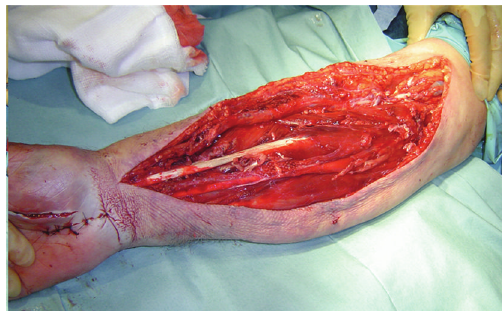
Figure 2: Fasciotomy with extensile Henry’s approach for forearm compartment